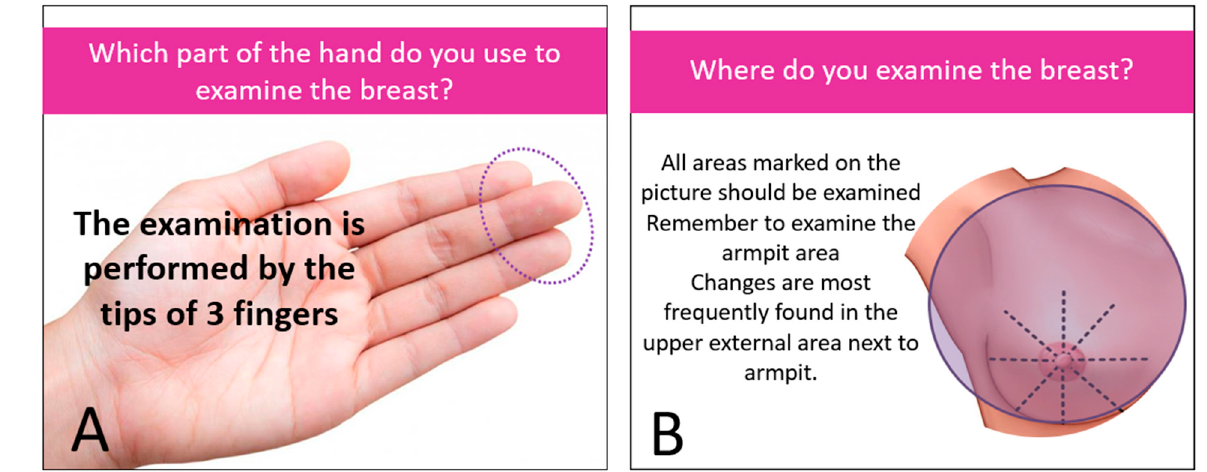
Figure 1. Personalized education. ( A ) example no.1 ( B ) example no. 2.